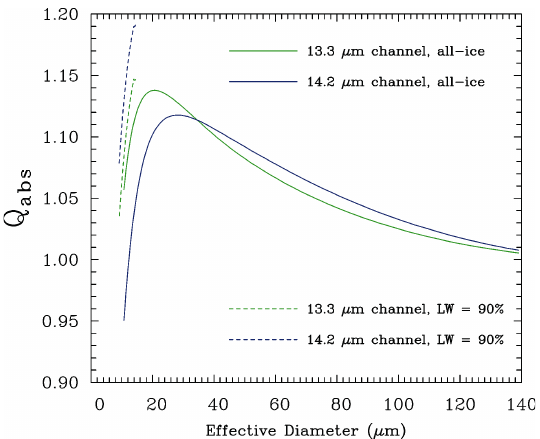
Fig. 1. Testing the temperature retrieval for all-ice and primarily liquid water (LW) conditions over a broad range of ice phase D e . Q abs is the area-weighted absorption efficiency of an ice particle size distribution (PSD), calculated here for two of the MODIS CO 2 channels. See text for details.